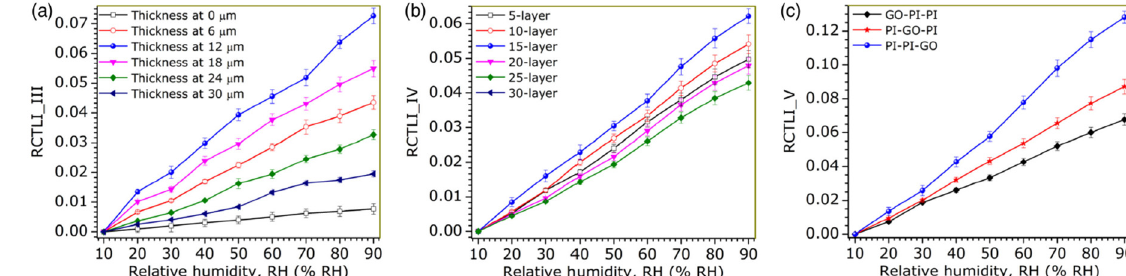
Figure 34. Point sensor. Effects of the ( a ) PI coating thickness, ( b ) number of GO coating layers, and ( c ) alternate PI–GO coating sequence on the sensitivities of the sensors at 25 C (sampling time: 10 s). Reprinted with permission from [183] © OSA .